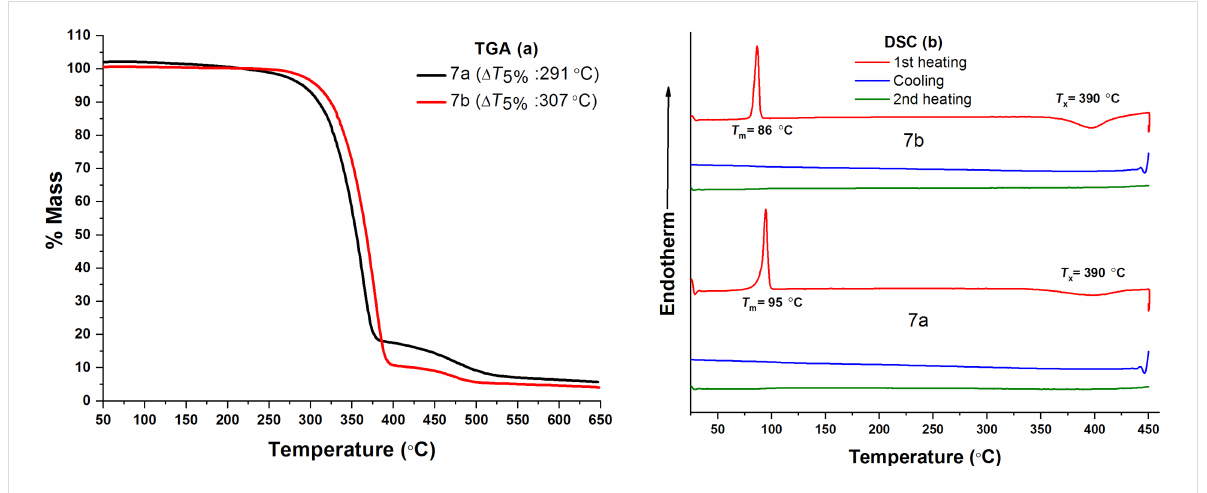
Figure 1: TGA (a) and DSC (b) curve of the compounds 7a and 7b .